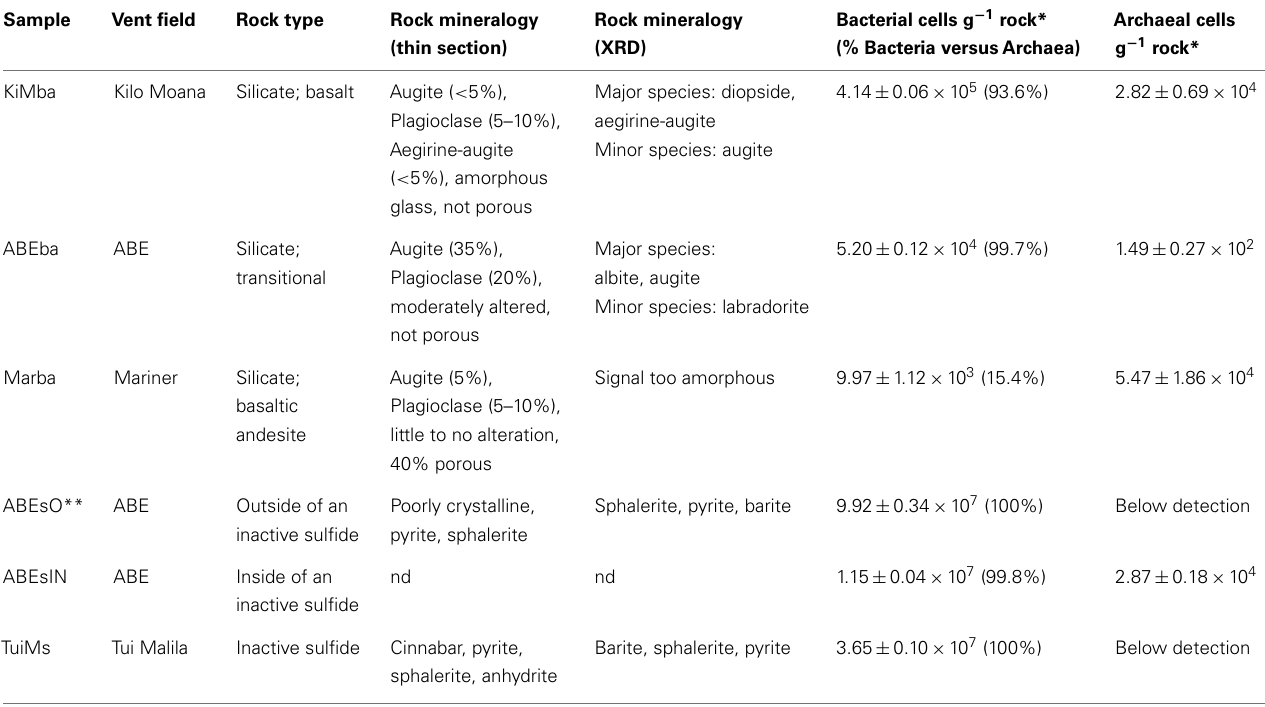
Table 1 | Samples descriptions and bacterial biomass